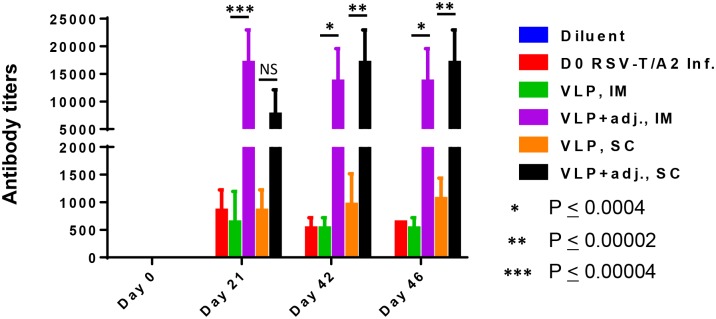
Induction of IgG titers in CRs immunized with VLPs and the virus.RSV-specific IgG levels in serum samples of CRs immunized twice were measured as already described. The histogram shows the results (mean ± SD, n = 3) of samples collected on days 0, 21, 42 and 46 for each of the started groups: IgG levels of adjuvanted VLPs on days 42 and 46 were significantly higher by both IM and SC routes compared to those induced by the virus and VLPs.